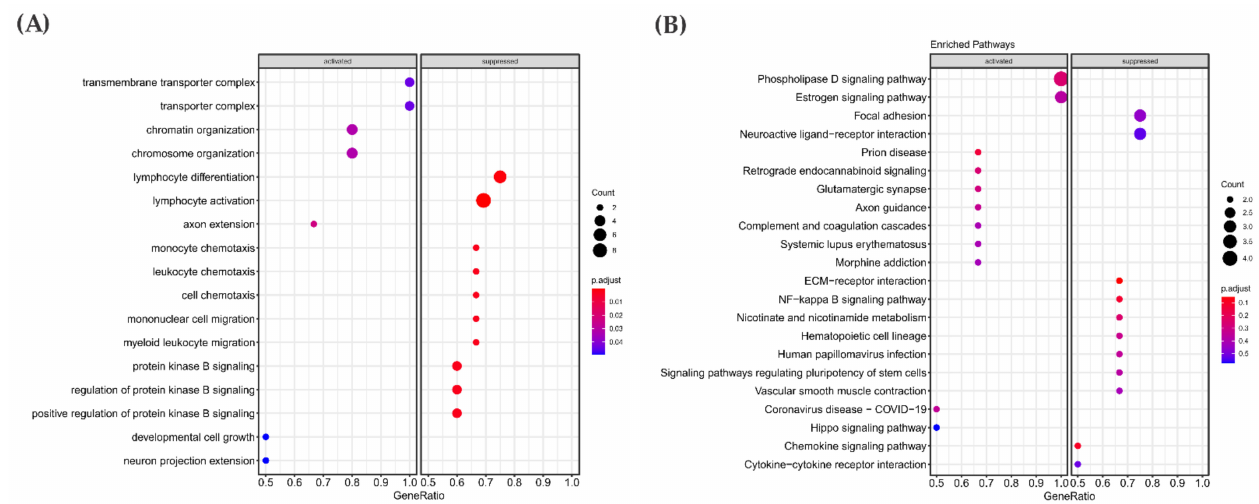
Figure 5. Differential gene expression analysis in the RAS -positive group from the discovery cohort (11 samples) detected 1765 genes significantly up- and downregulated. The top 10% ranked genes were differentially expressed, which shows that the ones with the lowest adjusted p -values were submitted to GSEA and KEGG enrichment to gain insight into altered biological processes and pathways. ( A ) GSEA enrichment analysis of biological processes that contain upregulated genes are marked on the left panel and downregulated on the right panel. ( B ) Pathway enrichment analysis (KEGG) results showed pathways in which most of their genes are upregulated (left) or down-regulated (right) in the RAS -positive